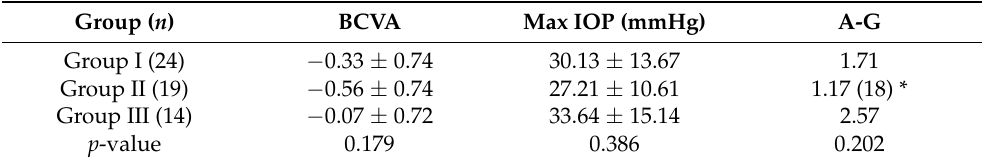
Table 3. Best-corrected visual acuity (BCVA), max intraocular pressure (Max IOP) and visual field defect (Aulhorn-Greve classification) in each Group.